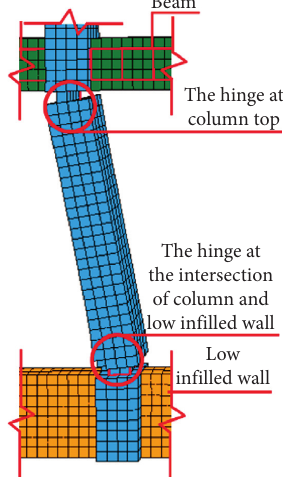
Figure 51: Failure state of first-floor middle